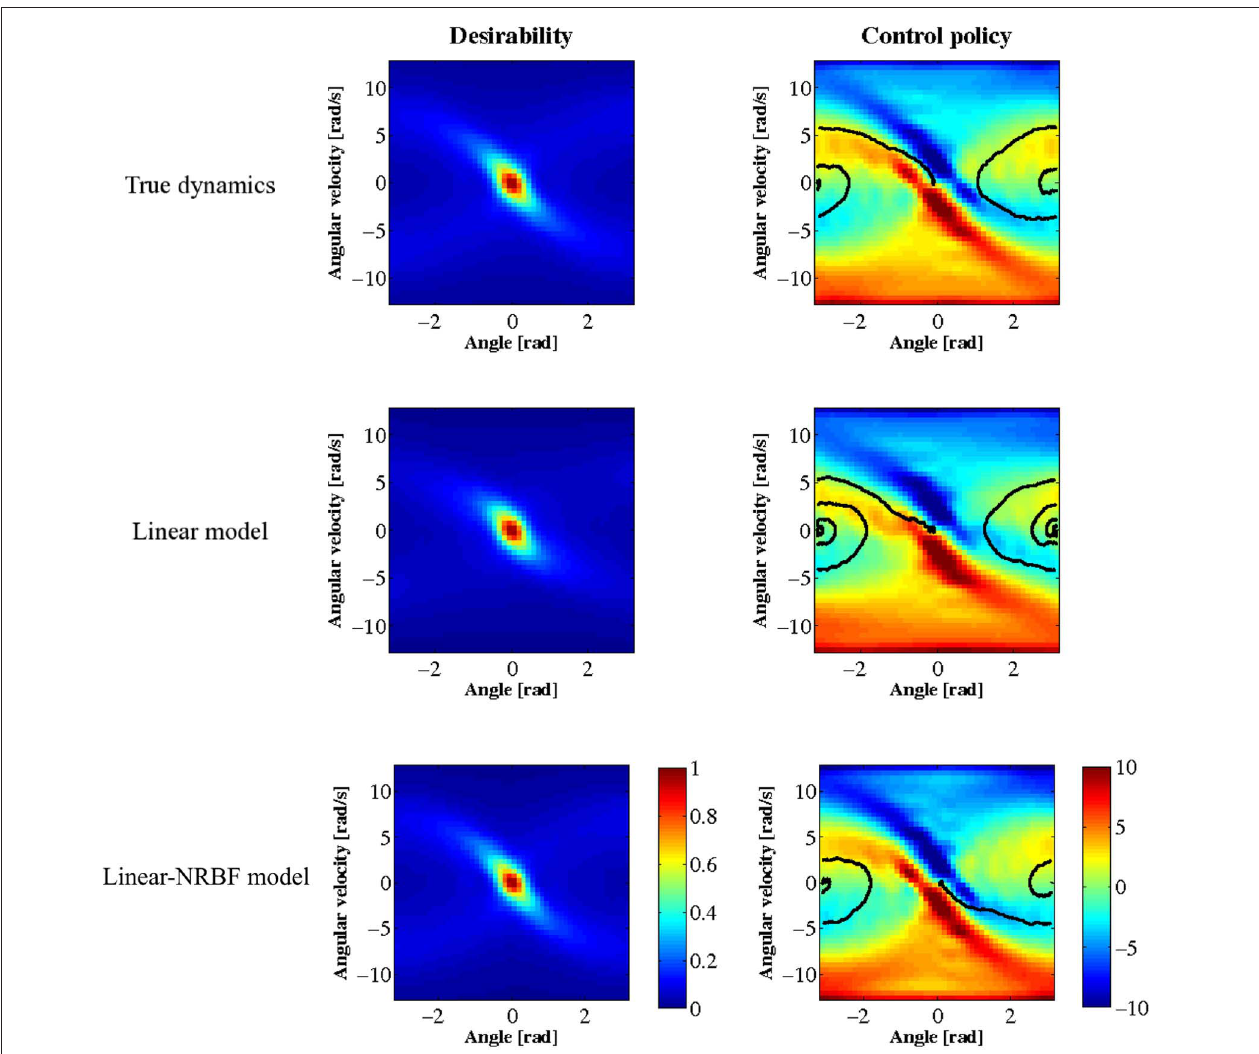
FIGURE 6 | Results of the swing-up pole task. z ( x ) is on the left, u ∗ ( x ) on the right, true dynamics at the top, linear model in the middle, and linear and NRBF model at the bottom. The black line shows a typical